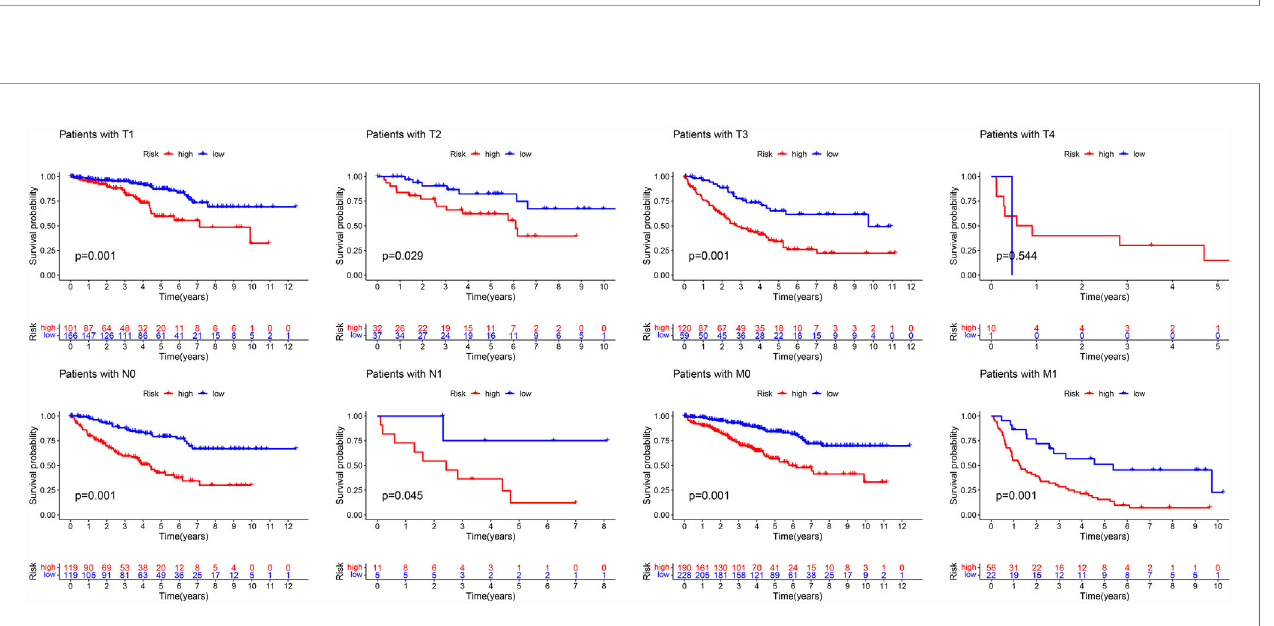
FIGURE 11 | Comparison of the ssGSEA scores. (A) The scores of 16 immune cells are displayed in boxplots. (B) The scores of 13 immune-related functions are displayed in boxplots. Adjusted P values were showed as: ns, not signi fi cant; *P < 0.05; **P < 0.01; ***P < 0.001.